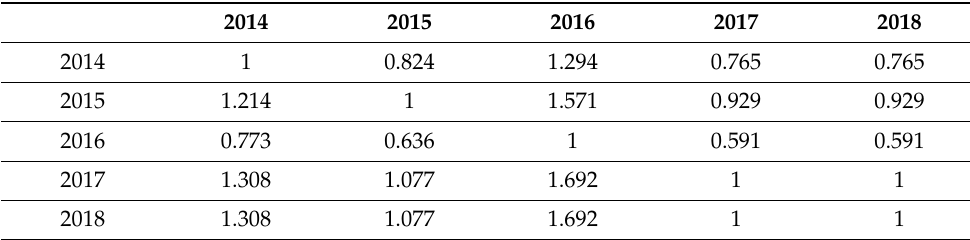
Table 5. Relative importance of social expenses over GPD (SER) in each year in the triangular fuzzy numbers (TFN) “Belgian SER in